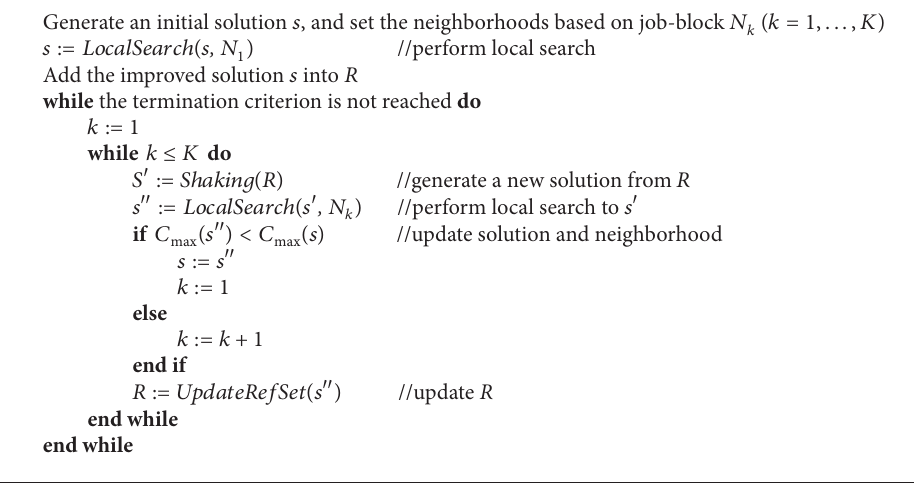
Algorithm 1: Main procedure of the proposed hybrid